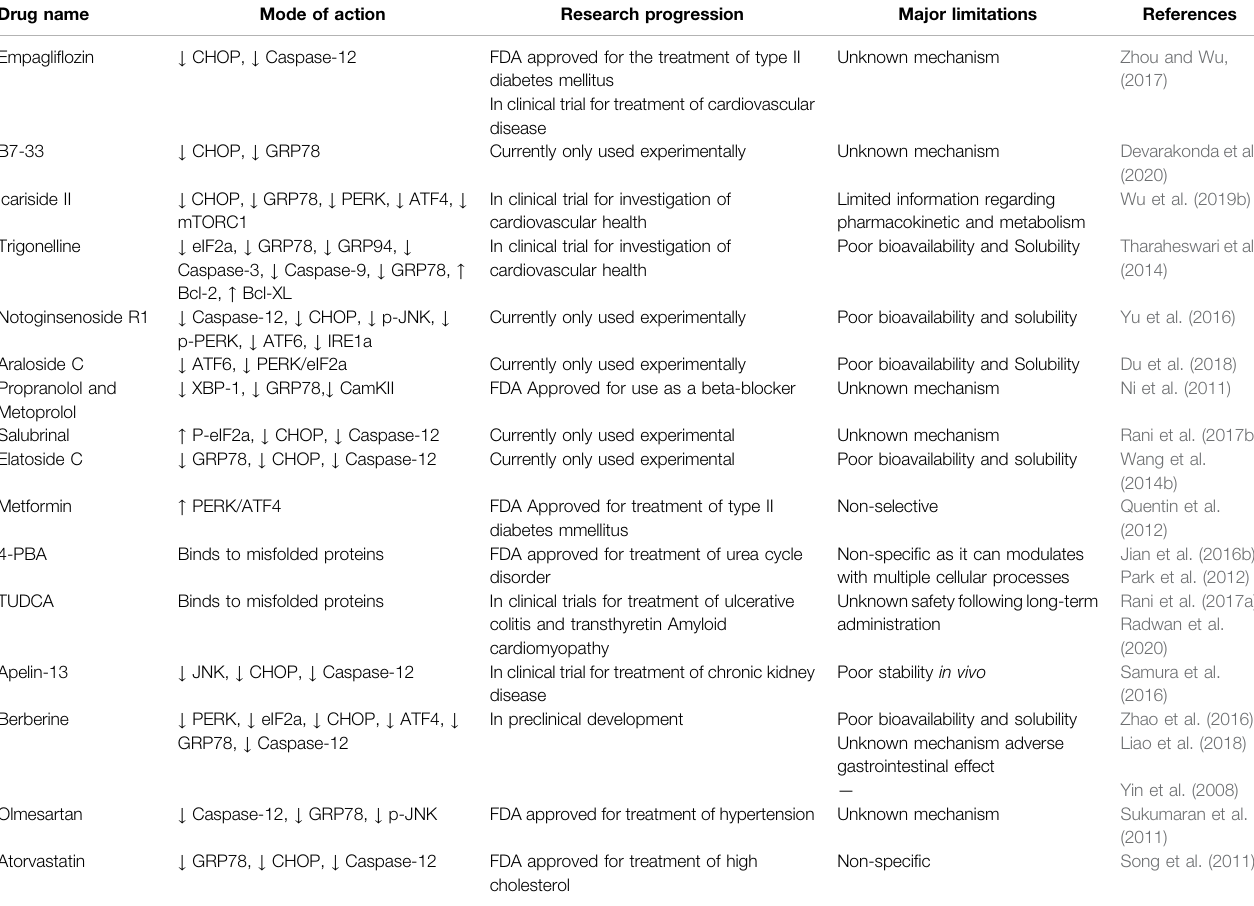
TABLE 2 | List of drugs shown to modulate unfolded protein